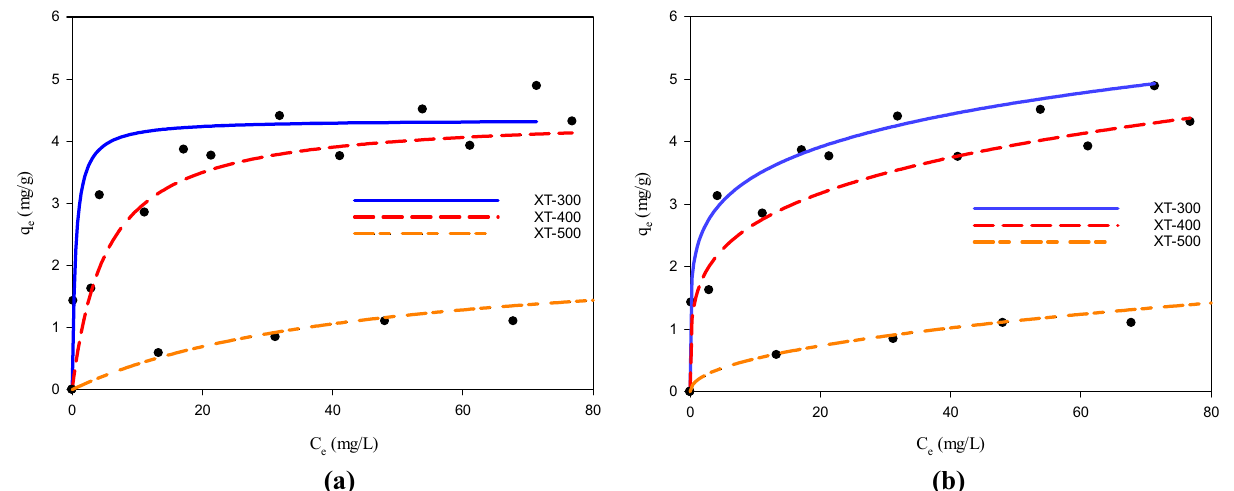
Figure 3. Adsorption isotherms of phosphate by adsorbents at different temperatures ( a ) Langmuir model, ( b ) Freundlich model.